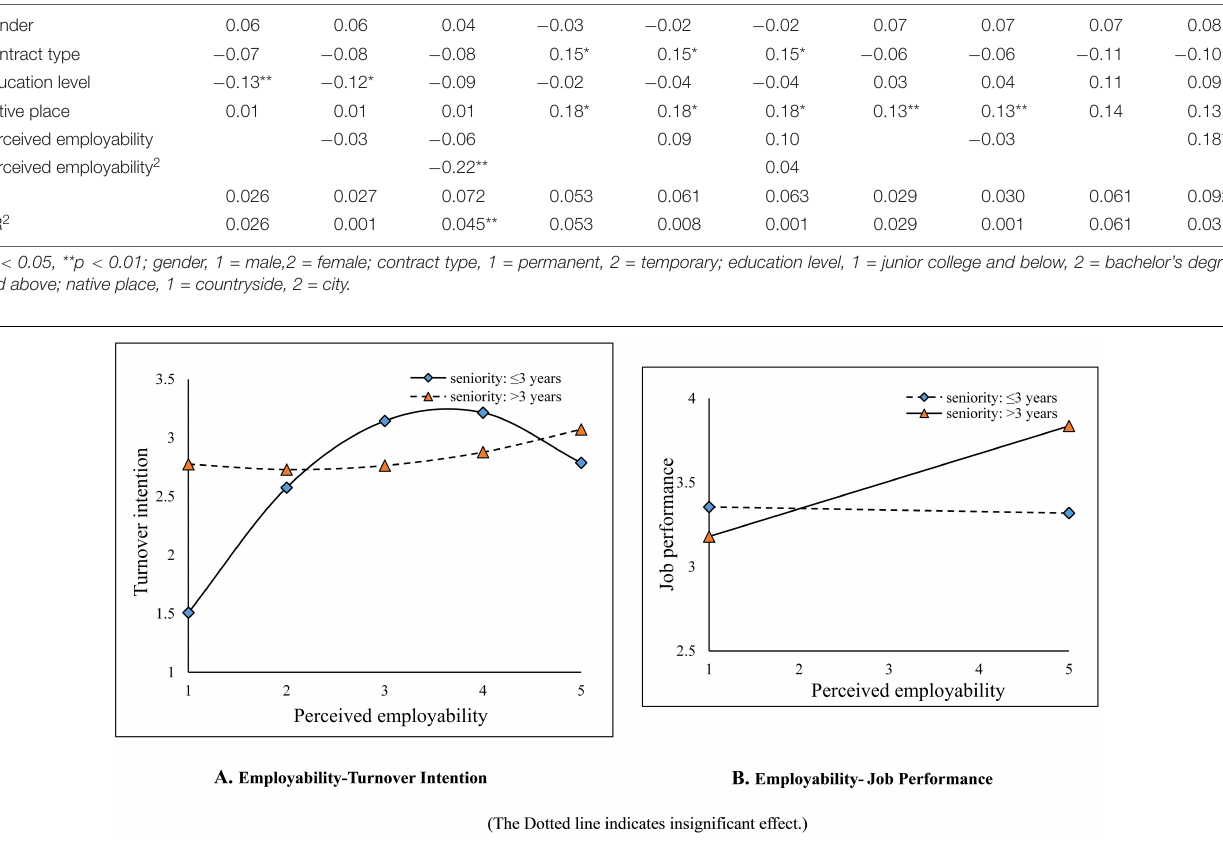
Frontiers in Psychology |